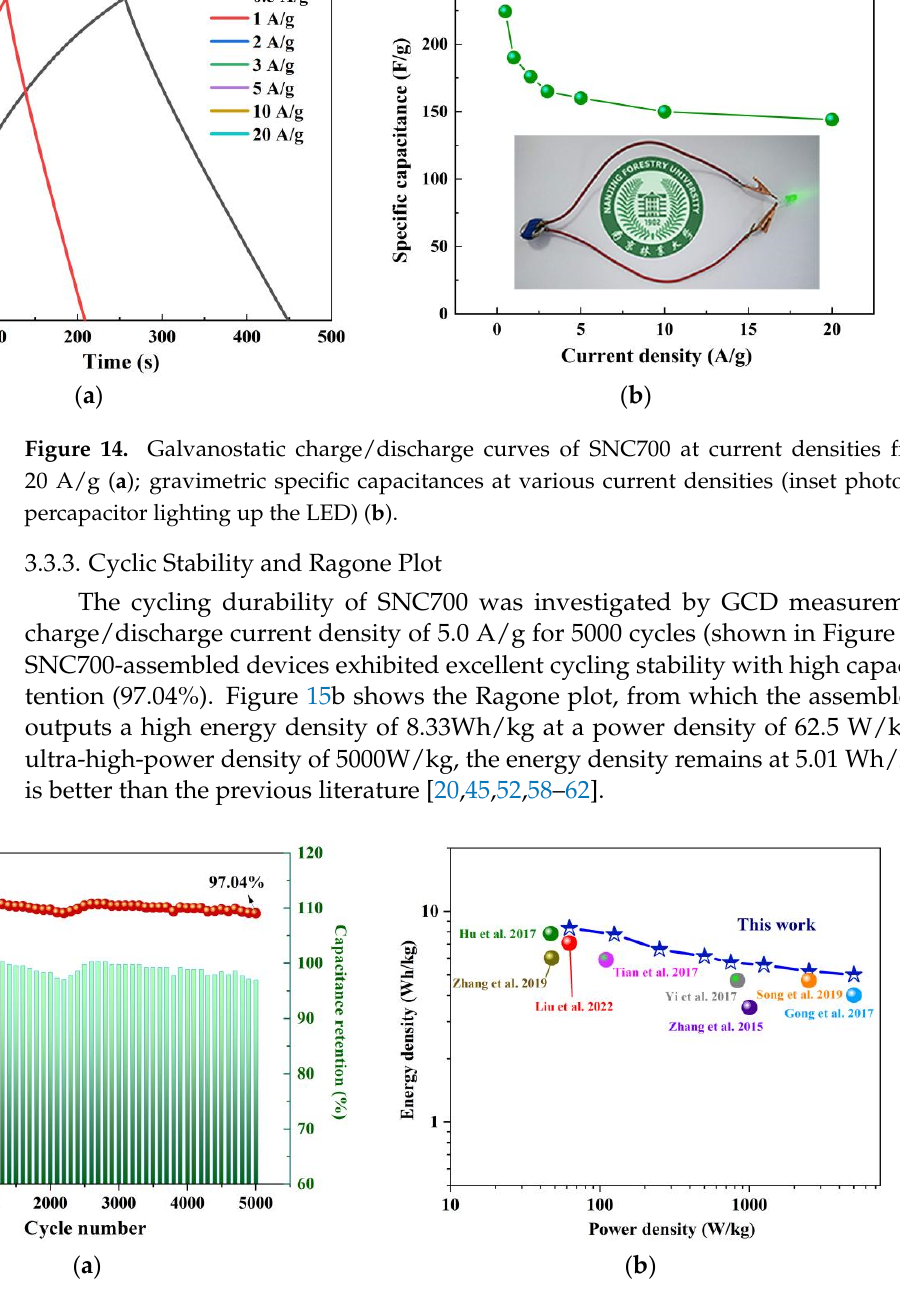
Figure 15. Cyclic stability of symmetric supercapacitors based on SNC700 ( a ); Ragone plot of symmetric supercapacitors based on SNC700 ( b ) [20,45,52,58–62].